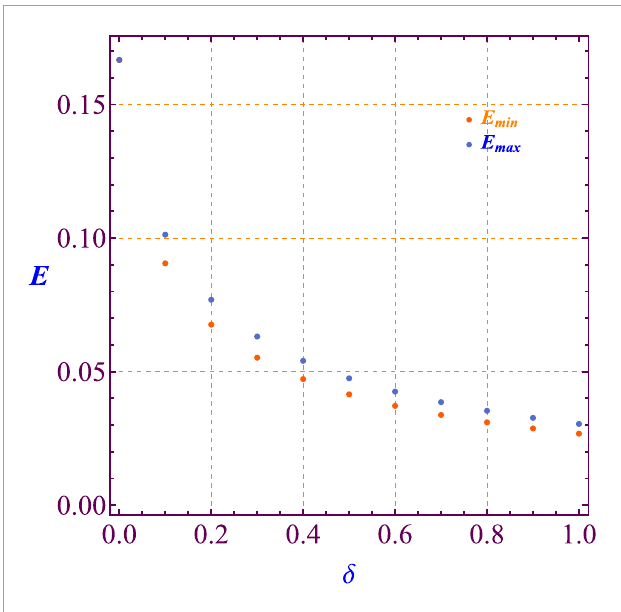
FIGURE 5 Critical values of energy versus transition parameter values for bounded motion ( E < E min ) and unbounded motion ( E > E max )